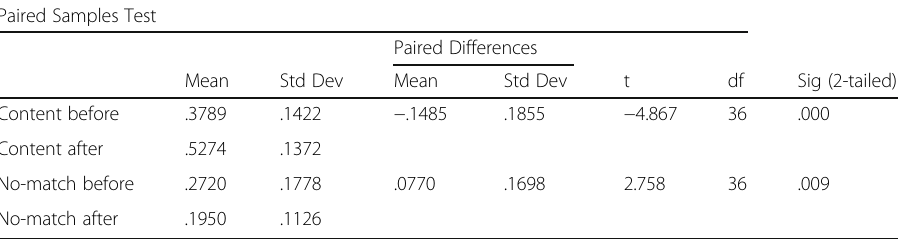
Table 3 Freud content and no-match counts before and after Intervention